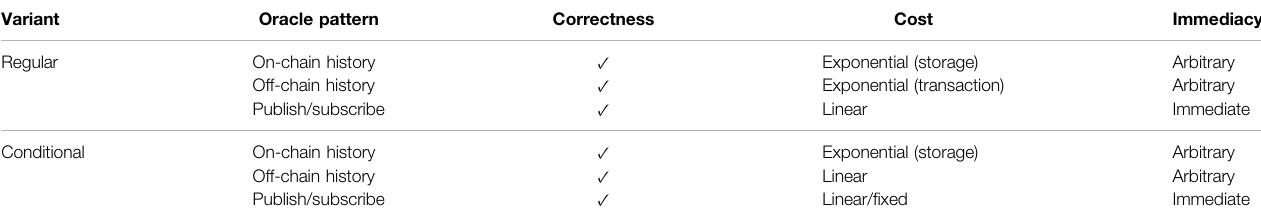
TABLE 5 | Relative comparison of the proposed oracle